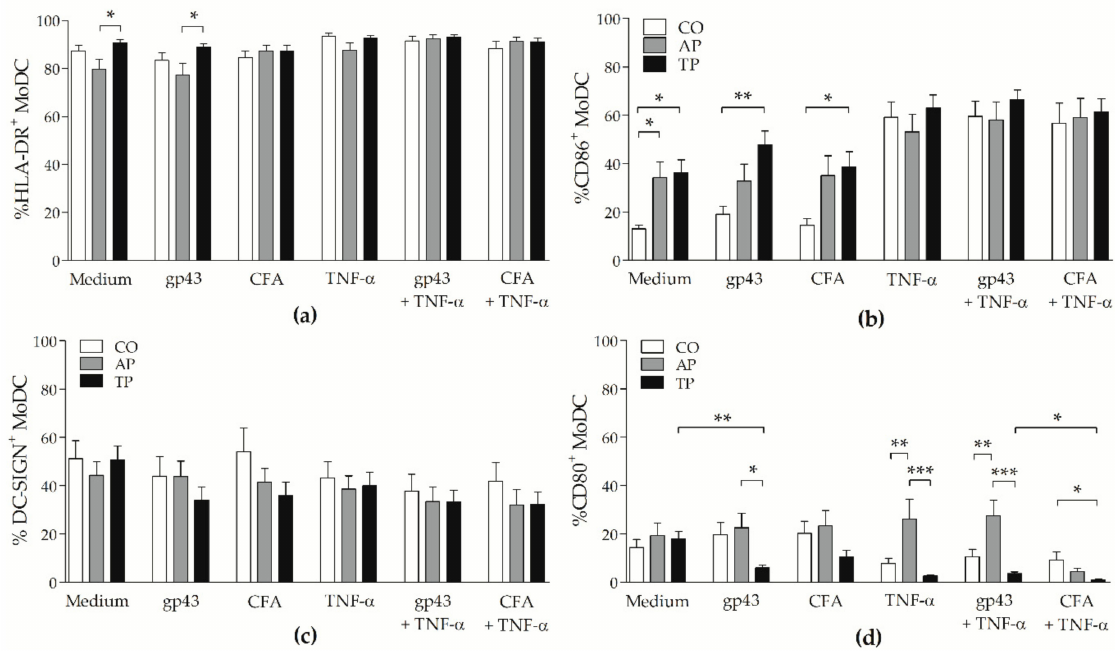
Figure 2. Influence of gp43 and CFA of P. brasiliensis on expression of surface molecules by moDCs: Percentages of ( a ) HLA- DR + , ( b ) CD86 + , ( c ) DC-SIGN + , and ( d ) CD80 + cells analyzed by flow cytometry on gated moDCs from non-PCM control subjects (CO: white bars; n = 15), and patients with active PCM (AP: grey bars; n = 17) or treated PCM (TP: black bars; n = 22), after 48 h of incubation with gp43 or CFA, with or without TNF- α , or left untreated (Medium). Results expressed as means with SEM of percentages; capped lines indicate statistically significant differences with respective p values: * p < 0.05, ** p < 0.01, or *** p <